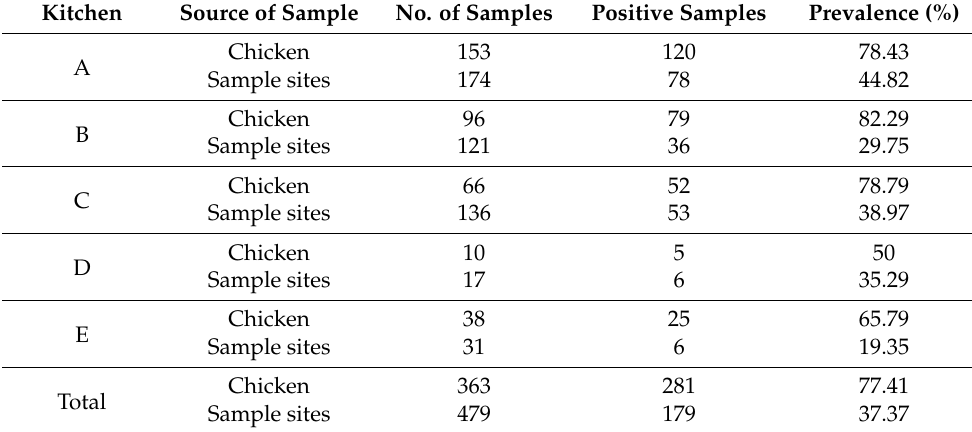
Table 1. Samples taken from each of the sampling sites at commercial kitchens in